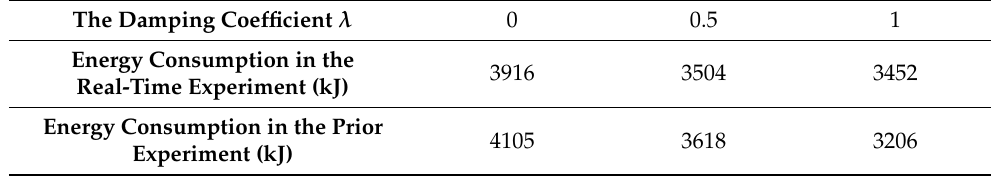
Table 2. Energy consumption corresponding to the intended driving